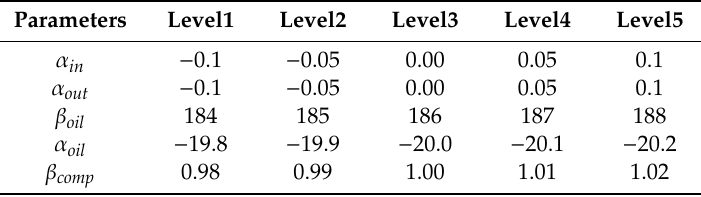
Table 4. Values of five levels corresponding to five factors.